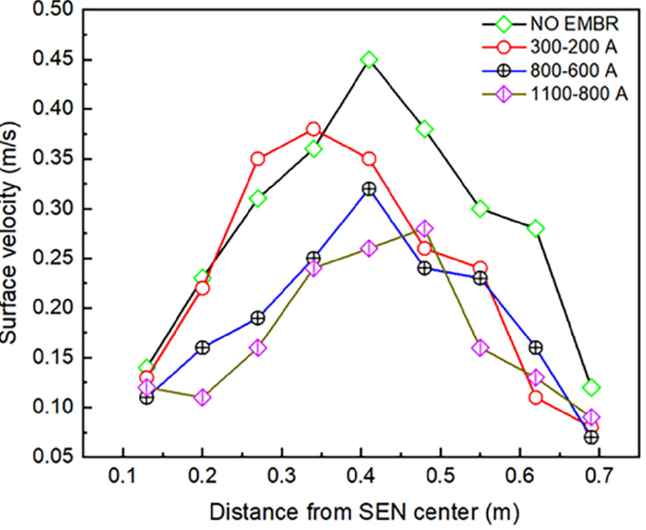
Figure 19. Funnel mold surface